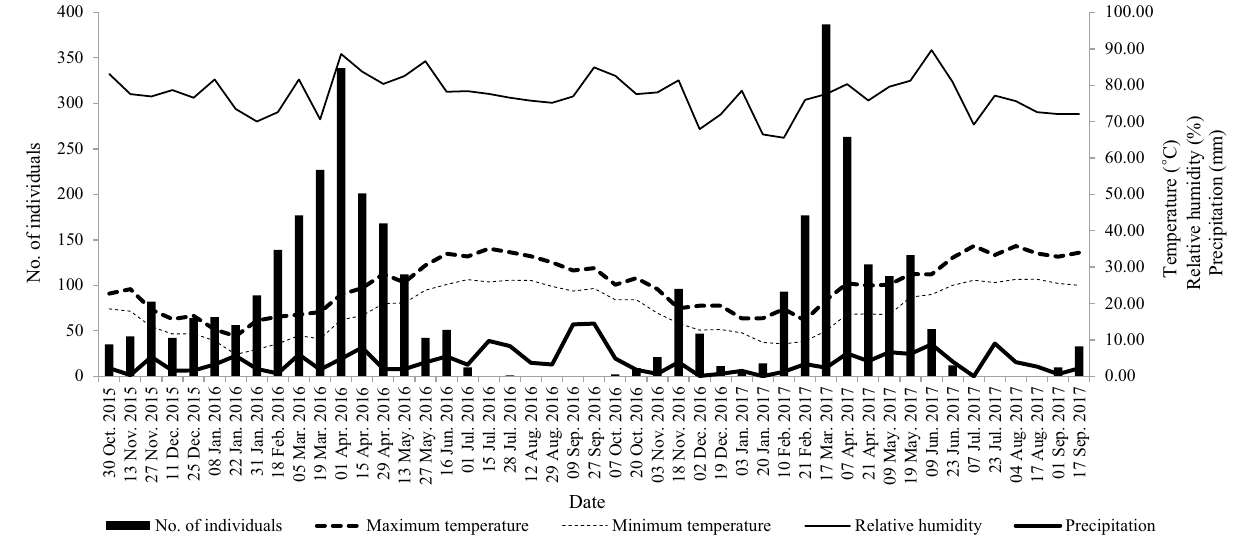
Figure 2. Trap catches of P. xylostella recorded every 2 weeks from October 2015 to September 2017. Average temperature minima, temperature maxima, mean relative humidity, and rainfall were measured every 2 weeks, with data being obtained from the daily recordings of a meteorological station located within the study Contour maps of spatial distribution. Two years contour maps created by the inverse distance squared weighted procedures exhibited a distribution pattern of P. xylostella in agricultural landscape (Figs. 4, 5). In Janu- ary 2016, the P. xylostella population was relatively low, mostly inhabited in the patch of A7. Then P. xylostella population continued to increase from February to March, and spread widely on farms, with a marked peak in April and the main hotspot located in patch A9. After May, the population decreased, with a small hotspot being observed in patch A9, and then the population declined sharply with very low number of individuals trapped (Fig. 4). March, large hotspots began to appear in B . oleracea fields (A4, A5, A8 and A9), and this pattern of distribution continued to May. In late May, with the harvest of cruciferous vegetables, only a small number of P. xylostella could be attracted and no hotspots were observed in June (Fig. 5).